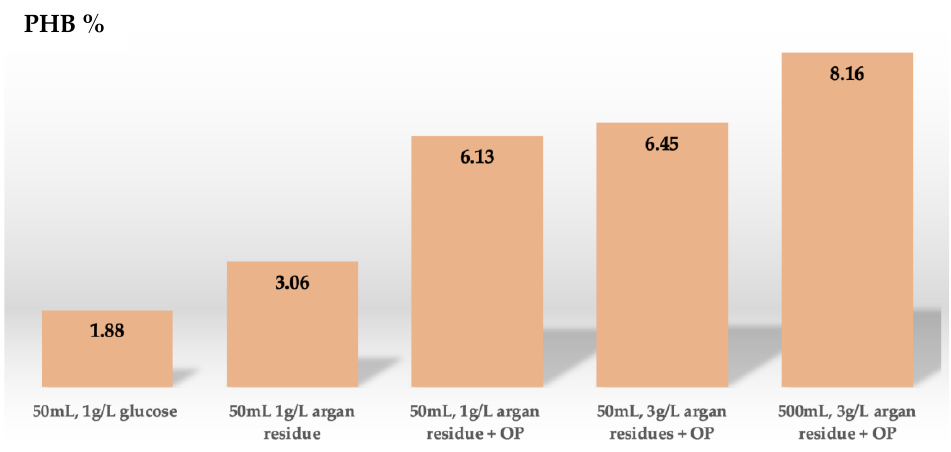
Figure 9. Progressive increase in putative PHB final yield throughout this work.